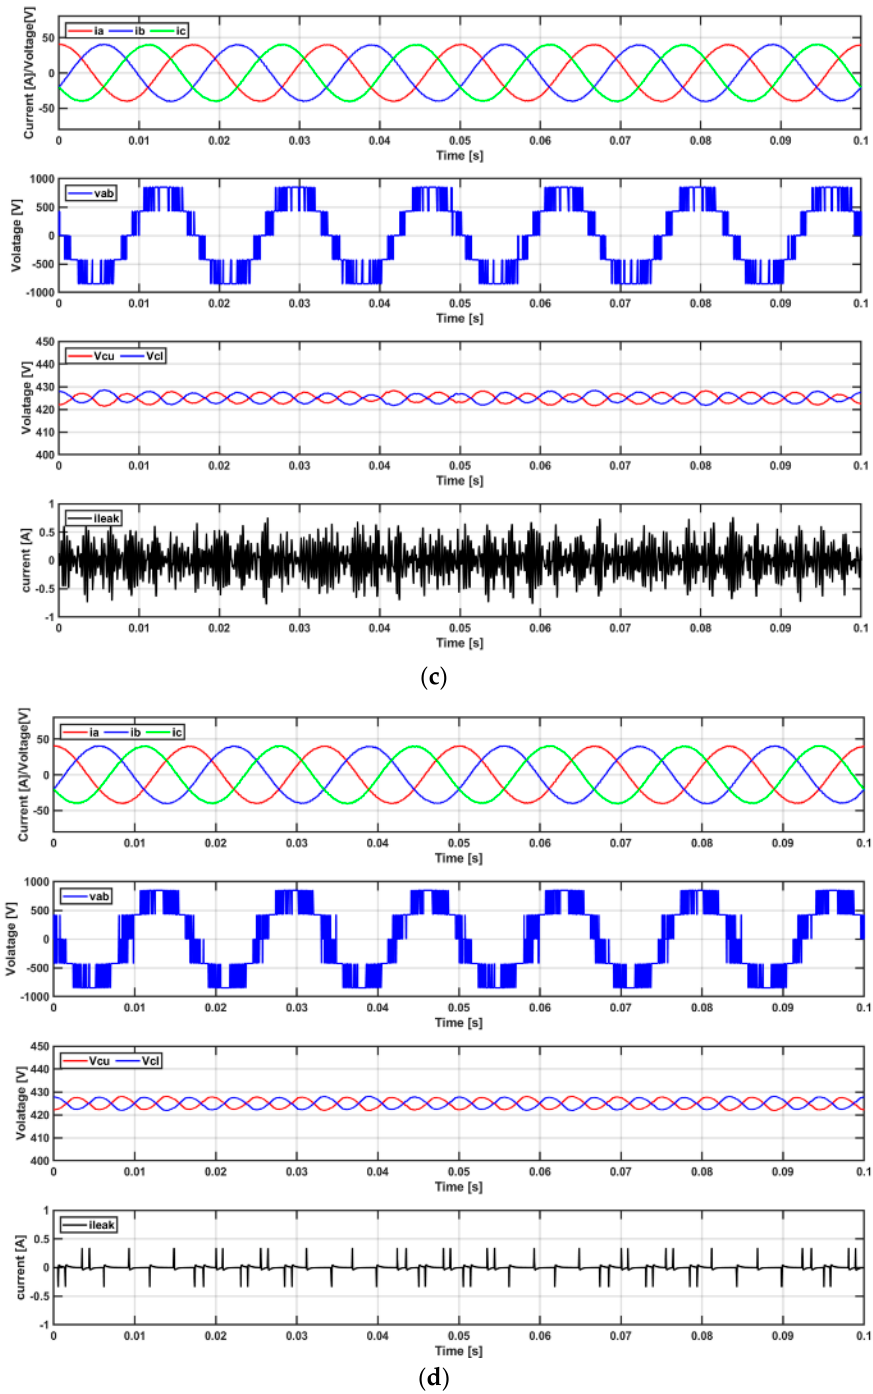
Figure 5. Comparison of output performance of a four-leg inverter (output current, output line voltage, DC voltage, leakage current) in balanced load conditions: ( a ) two-level three-leg four-wire type, ( b ) two-level four-leg type, ( c ) three-level three-leg four-wire type, and ( d ) three-level type four-leg inverter.